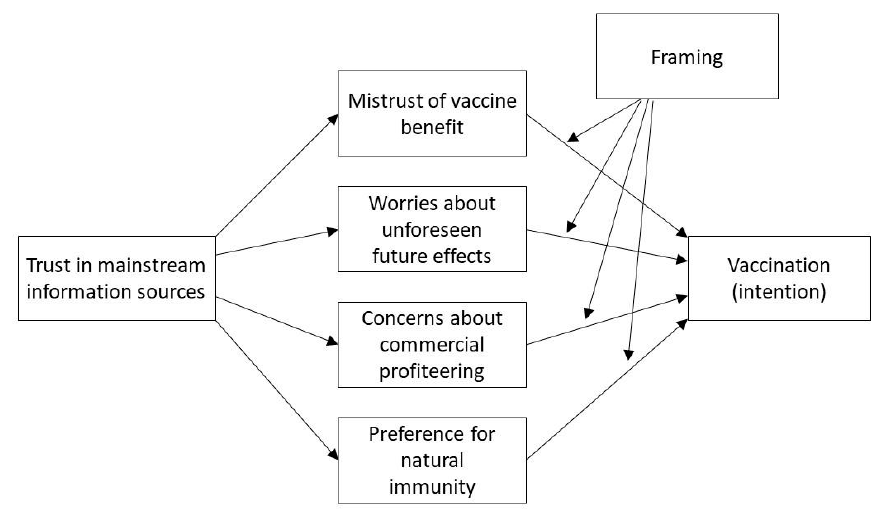
Figure 1. The hypothesized